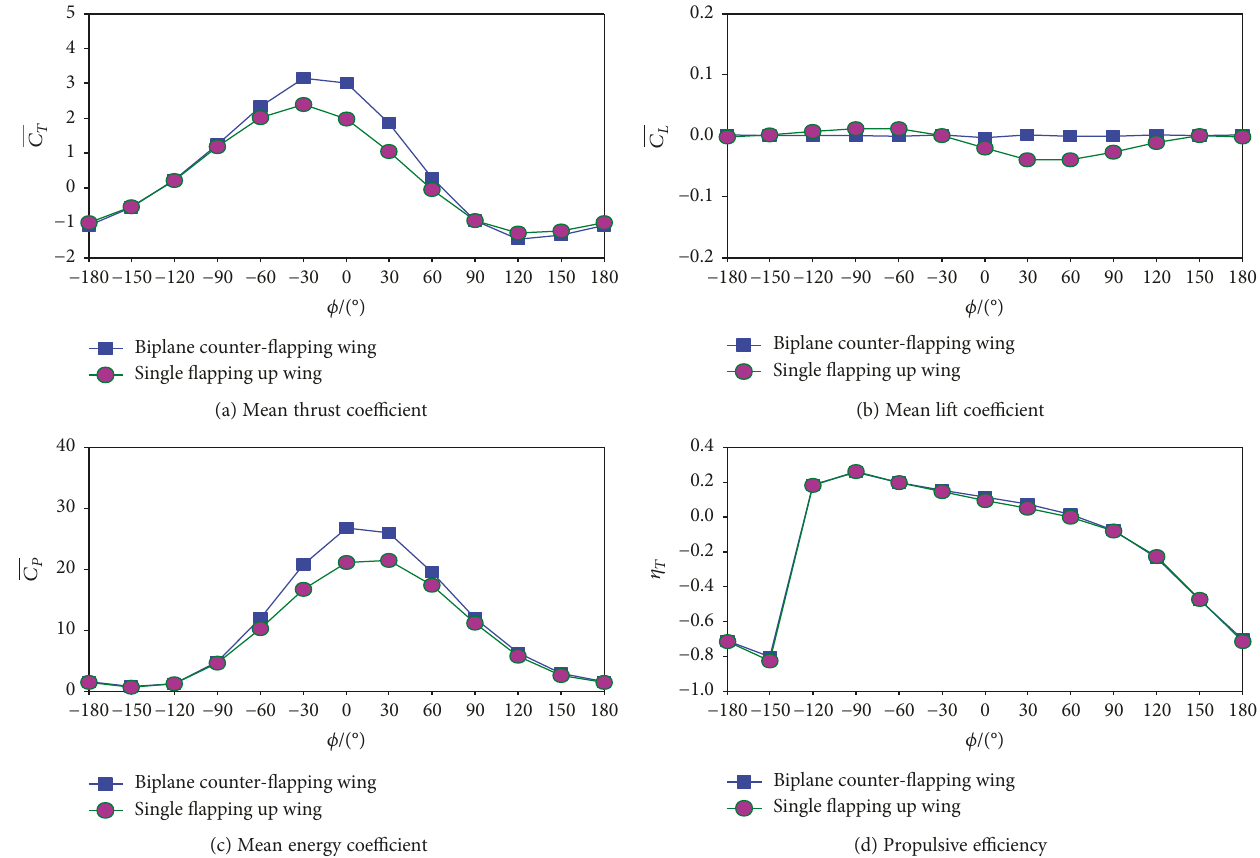
Figure 6: The performance of the biplane counter- fl apping wing and single fl apping up wing with di ff erent phase angle ϕ .